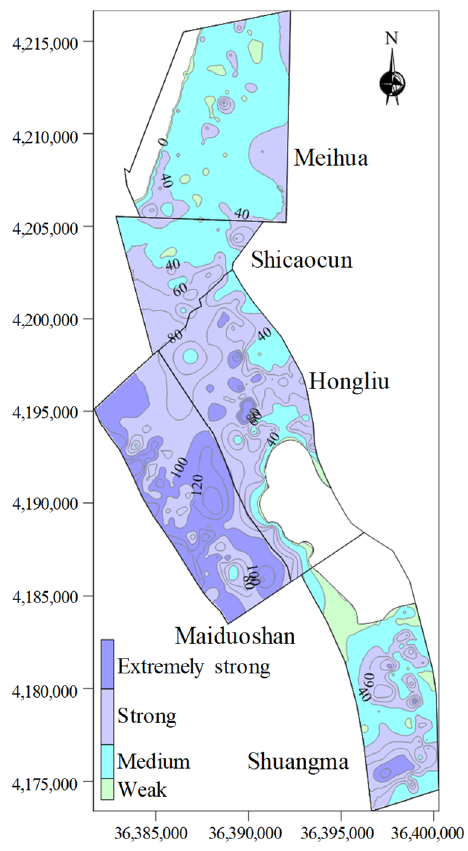
Figure 12. Water abundance zoning map by LII in roof water-conducting fracture zone of the study area.